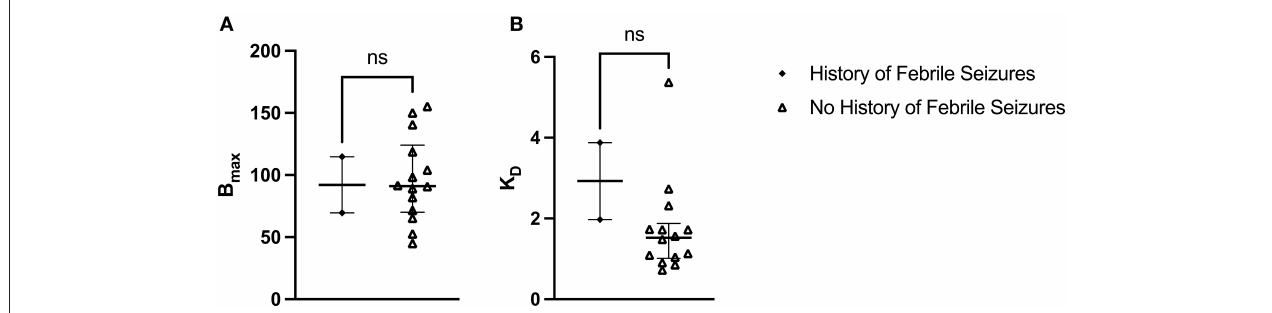
FIGURE 5 | [ 3 H]ABP688 B max and K D in patients with and without a history of febrile seizures. Receptor densities (B max ; in fmol/mg) and dissociation constants (K D ) in hippocampal specimens from mesial temporal lobe epilepsy (mTLE) patients with or without a history of febrile seizures. (A) B max values were not significantly different between patients with a history of febrile seizures and patients with no history of febrile seizures. (B) K D values were not significantly different between patients with a history of febrile seizures and patients with no history of febrile seizures. Values are represented as median with interquartile range; ns, indicates a non-significant